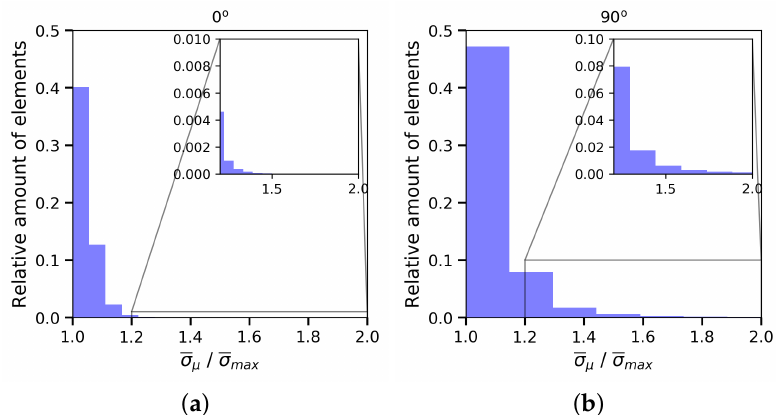
Figure 11. Histogram to represent, depending on the sample configuration ( a ) for 0 ◦ and ( b ) for 90 ◦ , the relative amounts of elements with local von Mises stress σ µ higher than the global one. The data involve the last frame of all simulations. σ max is the von Mises stress value from the true curves (Figure